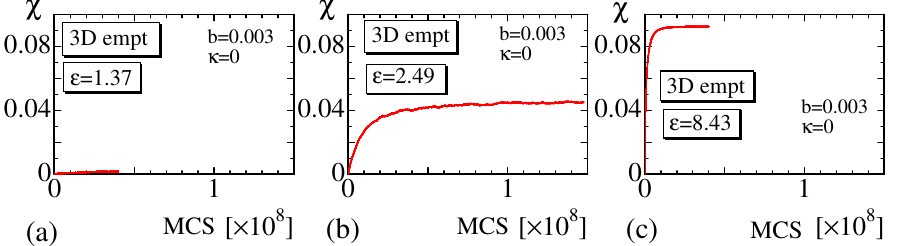
Figure 12. The crystallization ratio χ vs. MCS of the 3D empty model obtained at ( a ) ε (cid:39) 1.37, ( b ) ε (cid:39) 2.49, and ( c ) ε (cid:39)